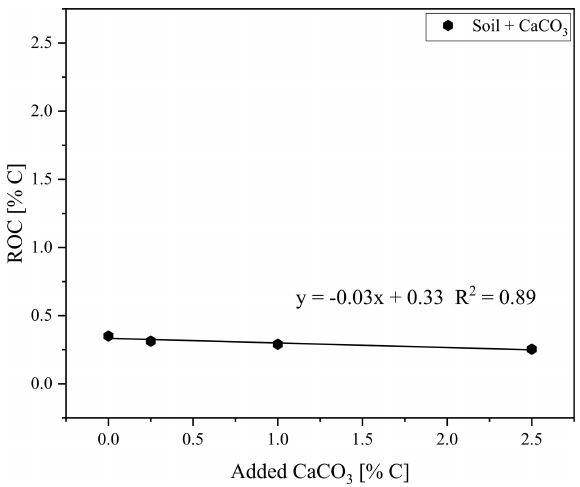
Figure 6. Residual oxidizable carbon (ROC) as measured with the smart combustion method plotted against the added CaCO 3 content to soil sample, used for creating calibration set